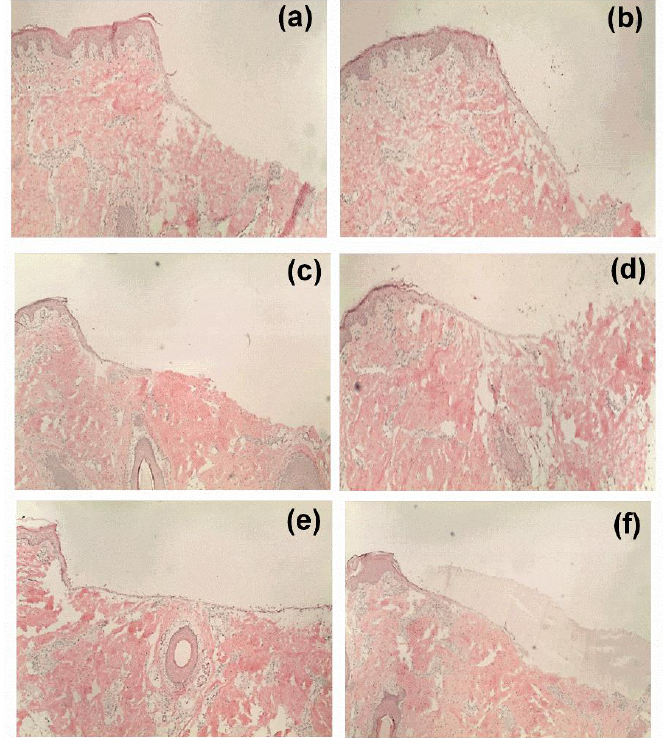
Figure 8. Microscopic observation: histological evaluations of wounds treated with TE-oleogel ( b ), pure PVA fiber mat ( c ), F1 ( d ), F2 ( e ), and F3 ( f ). ( a ) is the untreated control.